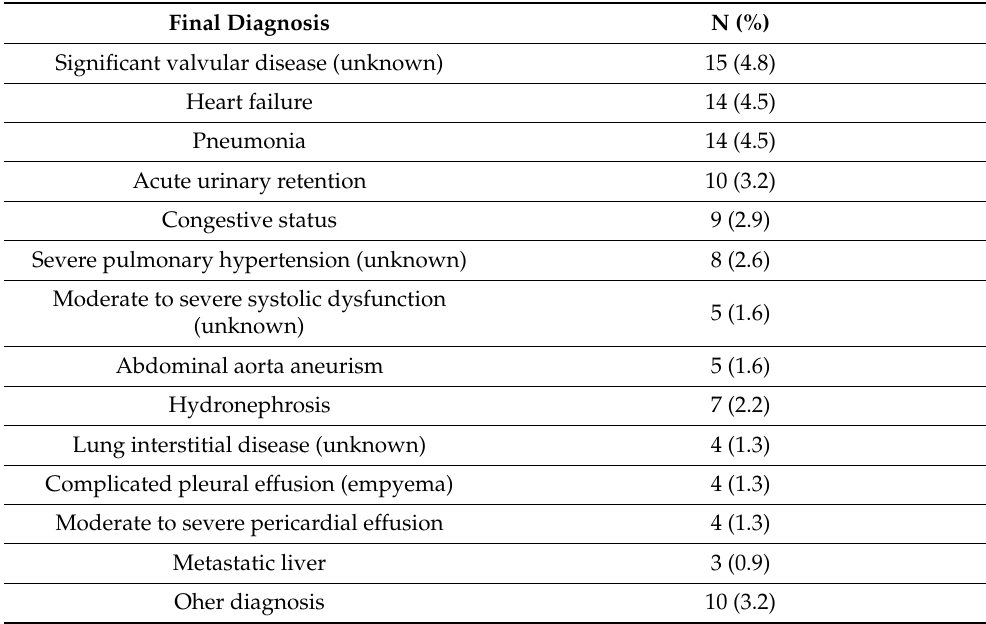
Table 3. Relevant unsuspected diagnoses detected after multi-organ point-of-care ultrasound (N =